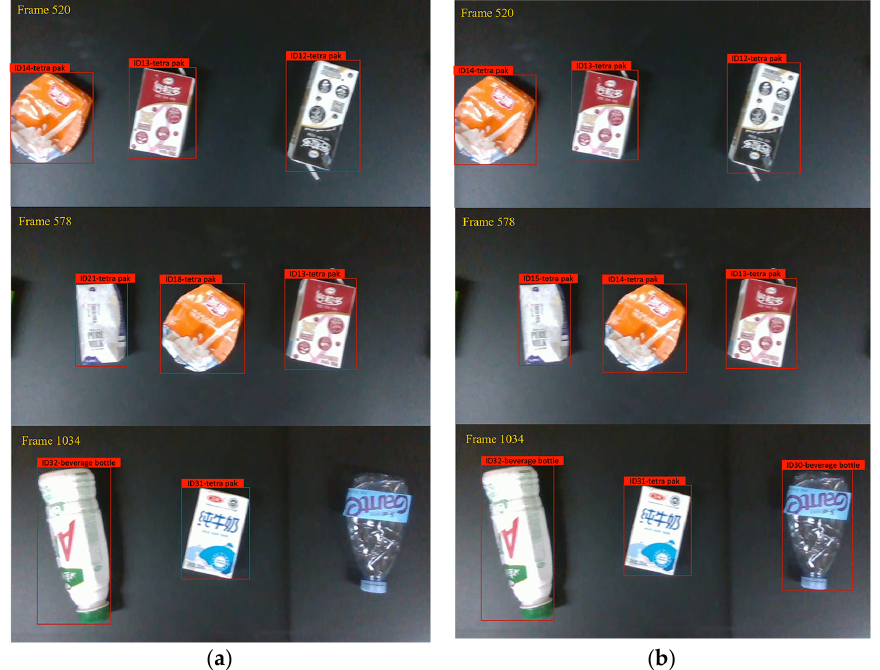
Figure 19. Comparison of tracking effect: ( a ) YOLOX + DeepSORT; ( b ) improved YOLOX + DeepSORT.